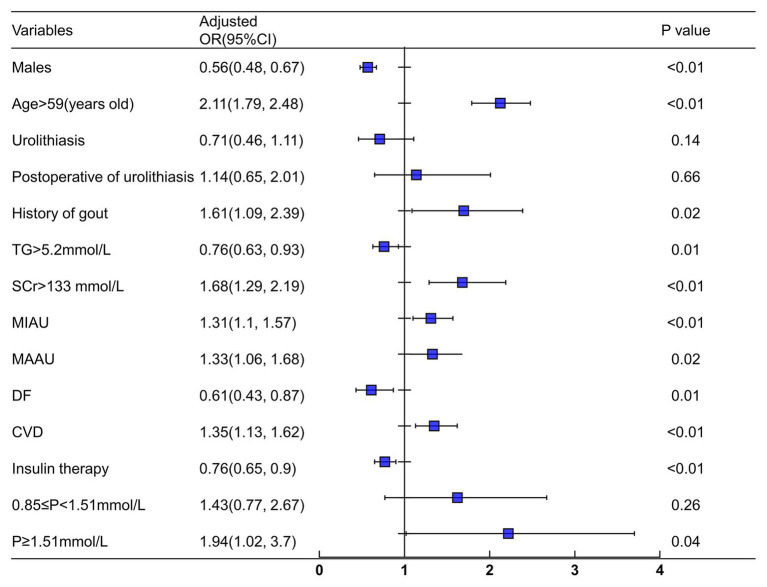
Logistic regression analysis for simple renal cysts. Adjusted confounders variables included gender, age, duration, smoking, drinking, urolithiasis, waist-hip ratio, HB, PLT, TG, Scr, ALB, FPG, HbA1c, 24 h urinary albumin, Ca, P, DK, DF, hypertension, CVD, fatty liver, UTI, CVD, and insulin therapy. SRCs, simple renal cysts; SCr, serum creatinine; TG, triglyceride; CVD, cerebrovascular disease; DF, diabetic foot; MIAU, microalbuminuria (30–300 mg/24 h); MAAU, microalbuminuria (>300 mg/24 h); DF, diabetic foot.